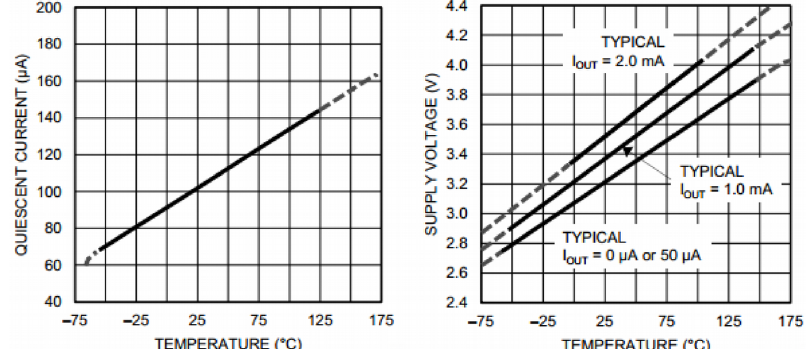
Figure 3. The current and potential difference change due to the temperature difference